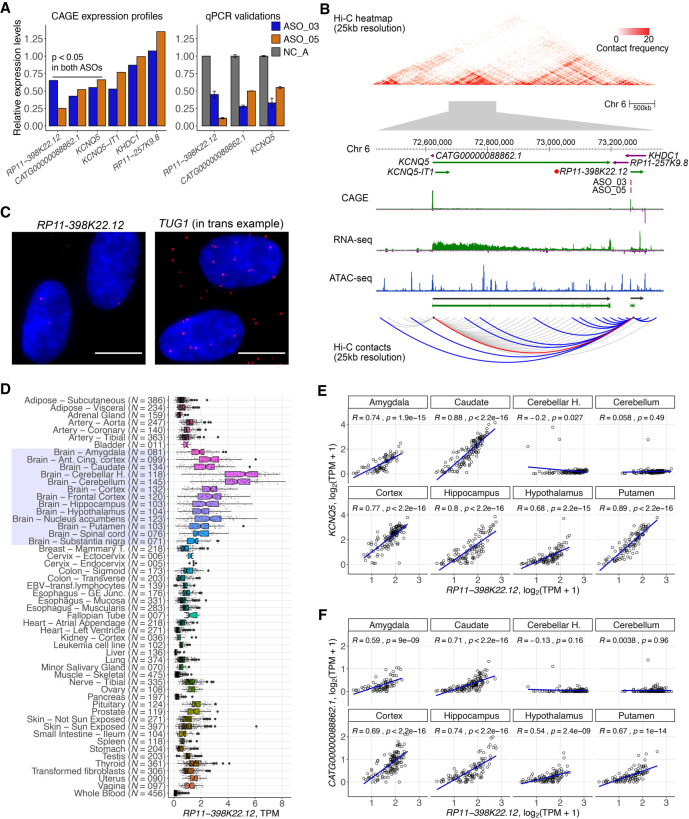
RP11-398K22.12 down-regulates KCNQ5 and CATG00000088862.1 in cis. (A) Changes in expression levels of detectable genes in the same topologically associated domain (TAD) as RP11-398K22.12 based on Hi-C analysis. Both KCNQ5 and CATG00000088862.1 are down-regulated (P < 0.05) upon the knockdown of RP11-398K22.12 by two independent ASOs in CAGE analysis (left) as further confirmed with RT-qPCR (right). (B) (Top) Representation of the chromatin conformation in the 4-Mb region proximal to the TAD containing RP11-398K22.12, followed by the locus gene annotation, CAGE, RNA-seq, and ATAC-seq data for native HDFs. (Bottom) Schematic diagram showing Hi-C predicted contacts of RP11-398K22.12 (blue) and KCNQ5 (gray) (25-kb resolution, frequency ≥ 5) in HDF cells. Red line indicates RP11-398K22.12 and KCNQ5 contact. (C) FISH image for RP11-398K22.12, suggesting proximal regulation. TUG1 FISH image (suggesting trans regulation) is included as a comparison; (bar = 10 µm). (D) GTEx atlas across 54 tissues (N = 9662 samples) shows relatively high expression levels of RP11-398K22.12 in 13 distinct brain regions samples (highlighted). (E) Expression correlation for RP11-398K22.12 and KCNQ5 in eight out of 13 distinct brain regions, as highlighted in D. (F) Expression correlation for RP11-398K22.12 and CATG00000088862.1 in eight out of 13 distinct brain regions, as highlighted in D.